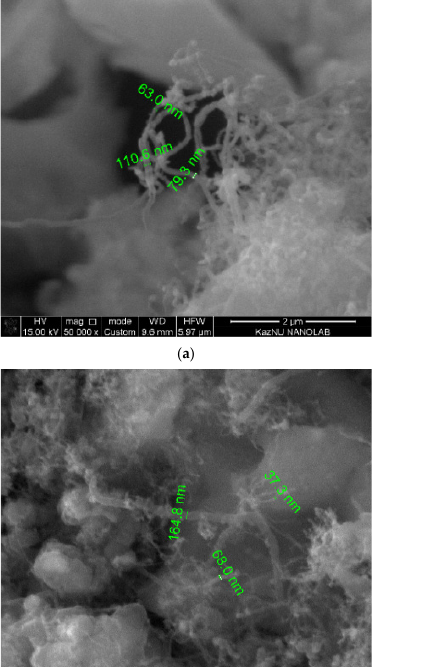
6H 2 O); ( d ) T = 800 ◦ C: at (1.5 M; CoCl 2 ·